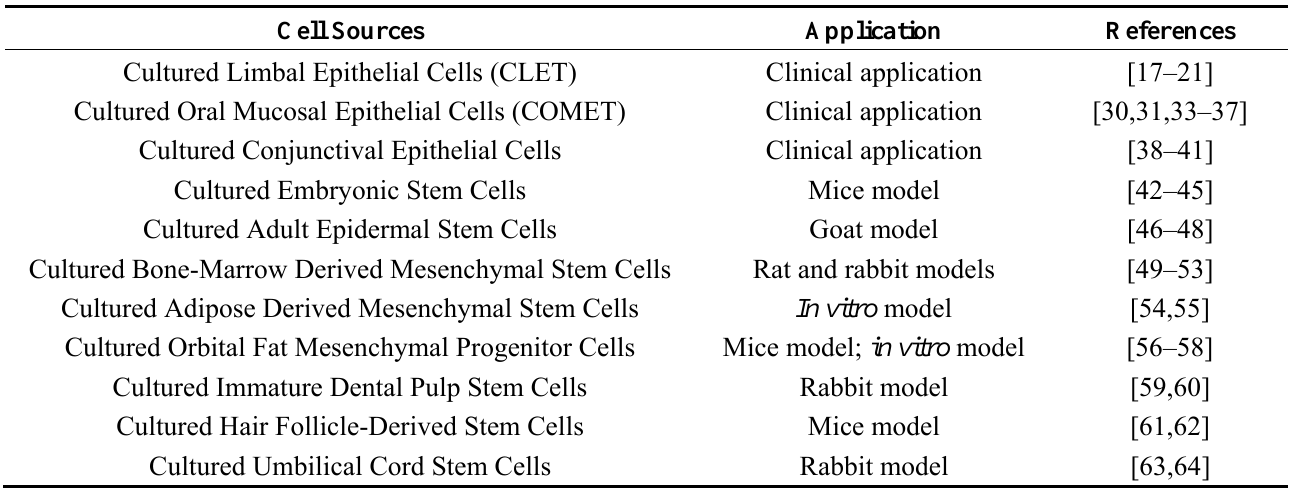
Table 2. Cell sources for ex vivo expansion cell-based therapy to treat Limbal Stem Cell Deficiency